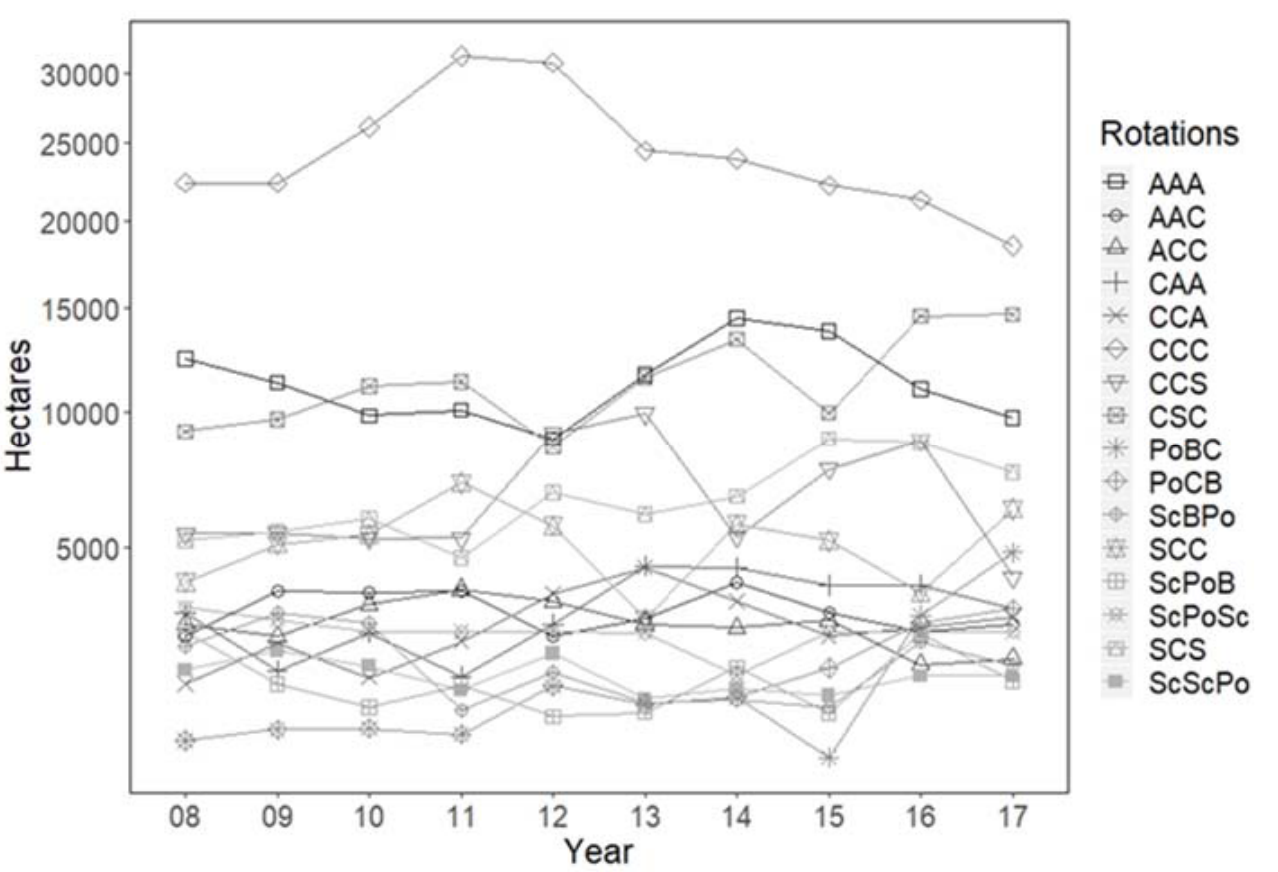
Figure 4. Dominant three-year rotations and their respective area totals for each year from 2008 to 2017. Total hectares on the Y axis are expressed with log scale. The following abbreviations correspond to the crop grown; C = corn, A = alfalfa, S = soybean, Sc = sweet corn, Po = potato, B = beans .